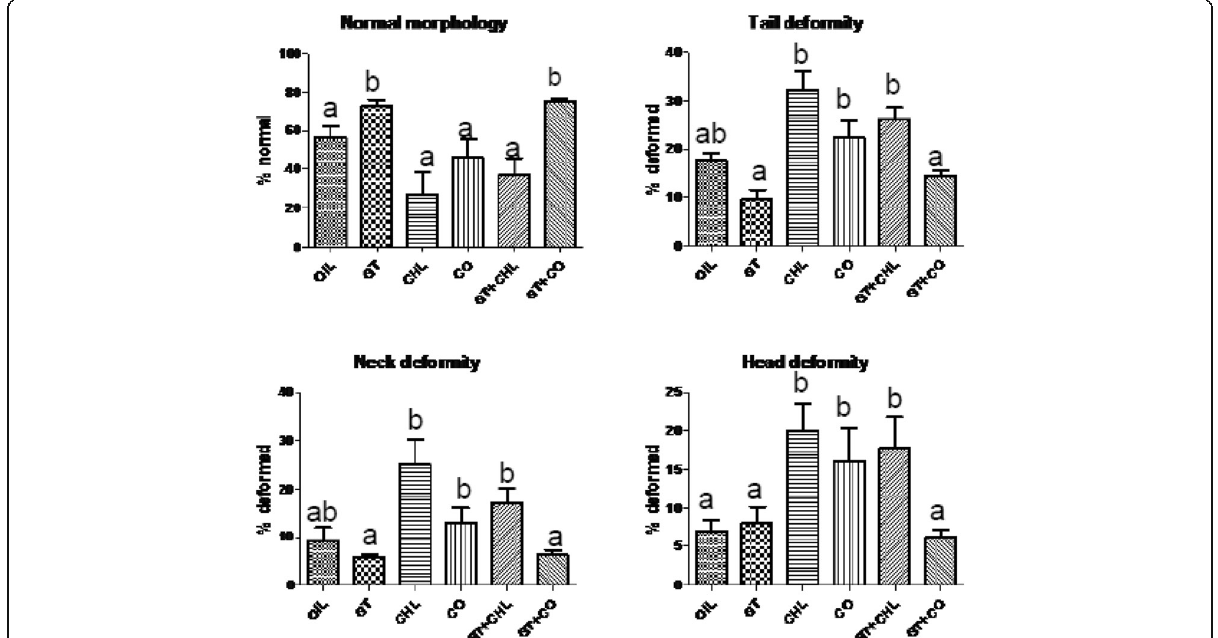
Fig. 4 Sperm deformity (%) in Wistar rats treated with mineral oil (OIL), green tea (GT), chlorpyrifos (CHL), extract of clove oil (CO), green tea and chlorpyrifos (GT+CHL), and green tea and extract of clove oil